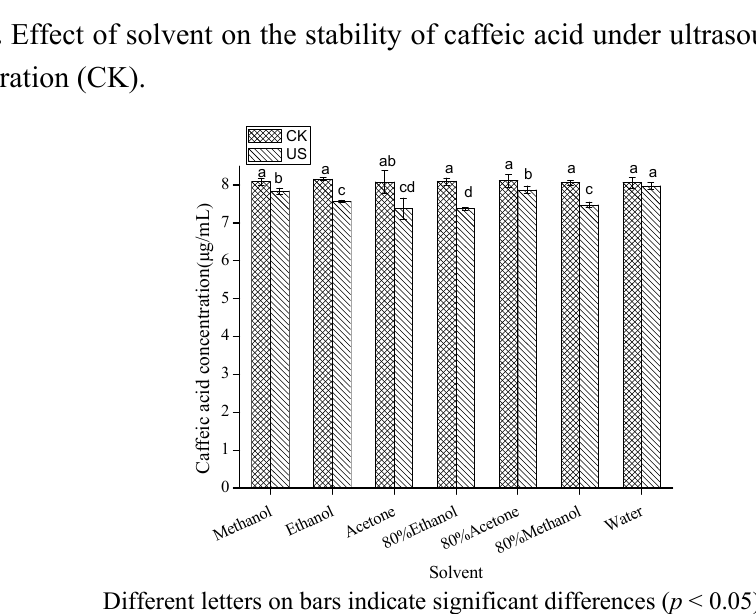
Different letters on bars indicate significant differences ( p < 0.05).